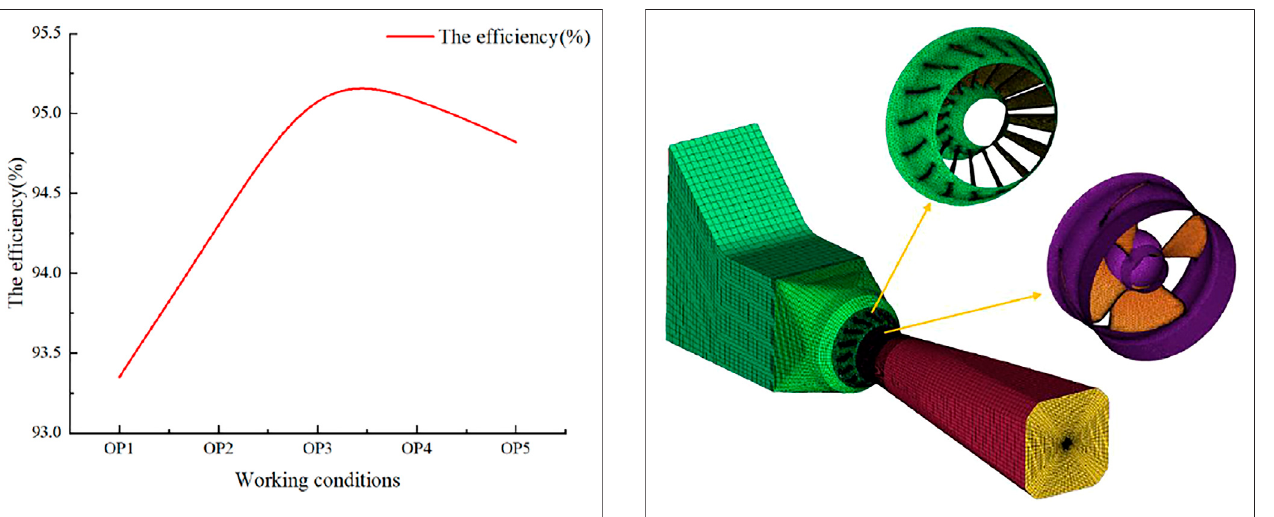
FIGURE 2 | Overall grid of the fl uid domain of the tubular turbine.